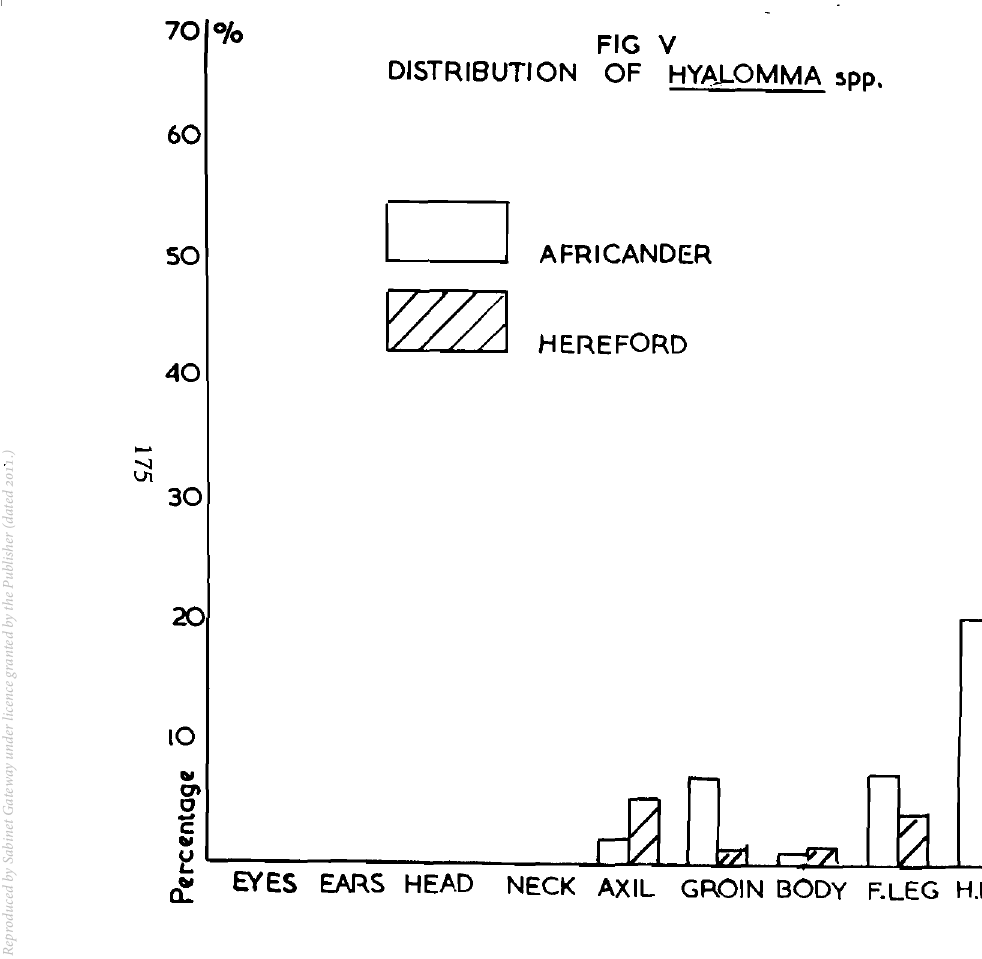
FIG V DISTRIBUTION OF HYALOMMA